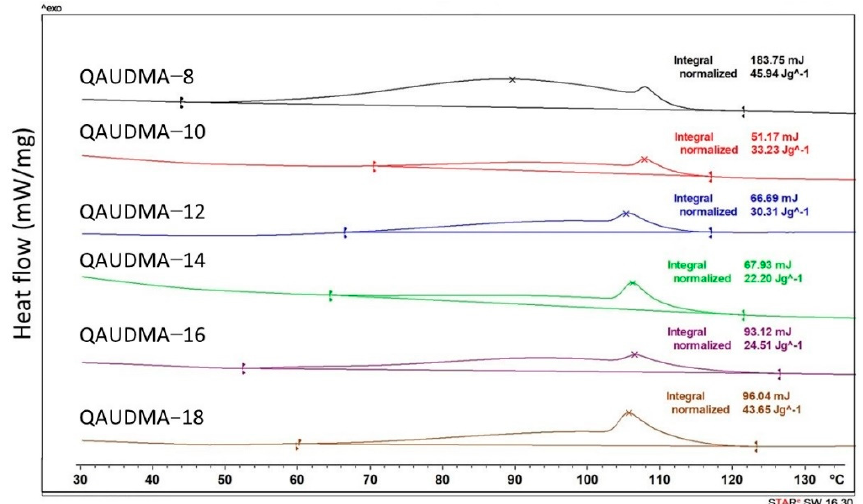
Figure 11. DSC thermograms of the QAUDMA polymers showing the post-polymerization peaks. On that basis, the DC DSC was calculated.